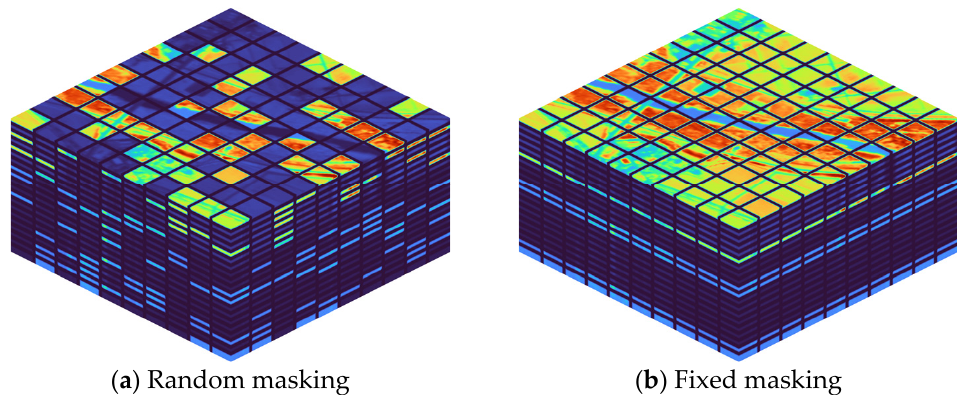
Figure 5. Schematic diagram of different training strategies applied to hyperspectral images. High- lighted areas are visible patches; dark areas are masked patches.